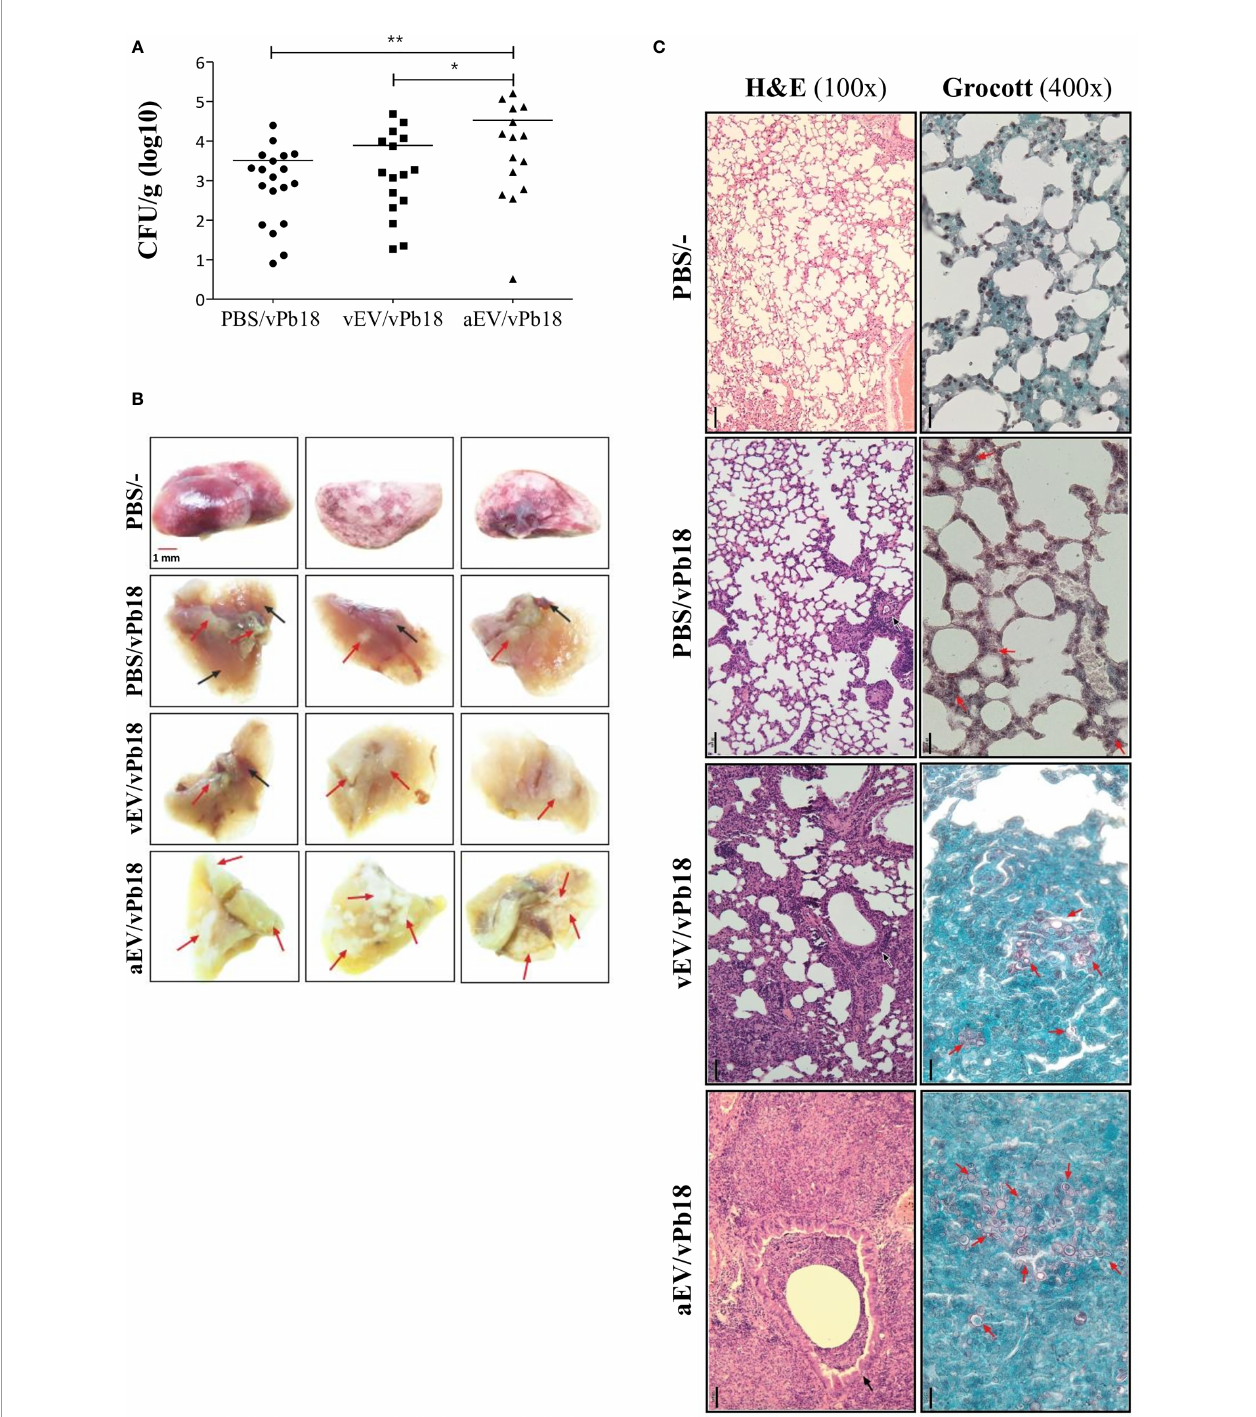
FIGURE 5 | Comparative effect of vEV and aEV treatment before vPb18 challenge in the PCM murine model. Groups of 10 Balb/C mice were treated subcutaneously with three doses, 7-day intervals, of 1 × 10 8 particles of vEV (vEV/vPb18) or aEV (aEV/vPb18) or with PBS (PBS/vPb18, positive control) before intratracheal infection with vPb18 (3 × 10 4 cells) 14 days after the last dose. (A) Fungal load in the lungs after 30 days of infection recorded as colony-forming units (CFU/g of organ). Standard deviations are shown with bars and signi fi cant results are indicated as * p < 0.05 and ** p < 0.01. (B) Macroscopy of representative lung samples from three different animals (columns), including non-infected controls (PBS/ − ). Black and red arrows point to, respectively, normal and damaged tissue. (C) Histopathology of lung sections stained with hematoxylin – eosin (H&E, ×100 magni fi cation) or Grocott (×400 magni fi cation), as indicated. Black bars correspond to 20